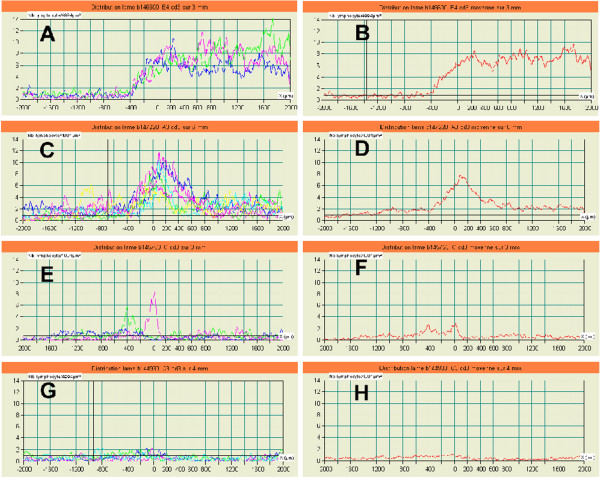
Left side (A, C, E, G): Curves derived from different measures performed on 4 tumors. Right side (B, D, F, H): Different pattern of lymphocytic infiltration defined according to the mean curve derived from the different measures in A, C, E and G respectively. Pattern 1: High density of positive lymphocytes within the tumors (A, B). Pattern 2: High Peak of lymphocyte density within the non-tumorous tissues localized nearby the tumors (C, D) and Low Peak of lymphocyte density within the non-tumorous tissues localized nearby the tumors (E, F). Pattern 3: Uniform low lymphocyte density (G, H).